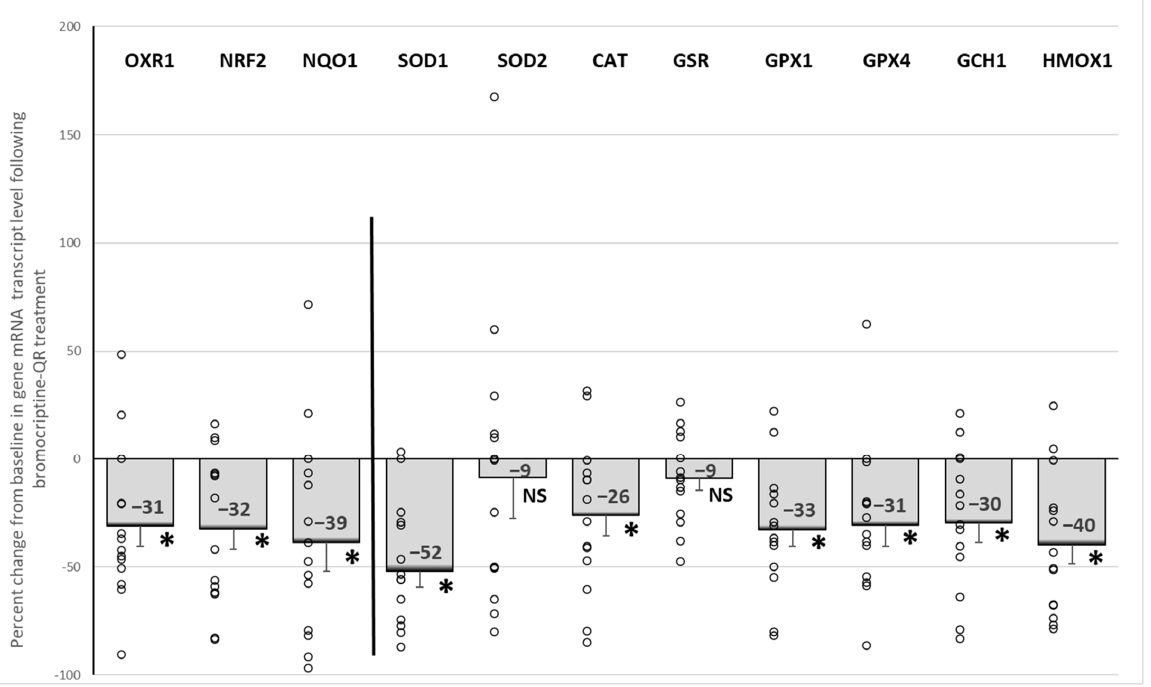
Figure 4. Effect (change from baseline) of 4 months of bromocriptine-QR treatment on the PBMC oxidative stress response (antioxidant) gene mRNA level. * Significant, 2-tailed t -test; NS, Not Significant.